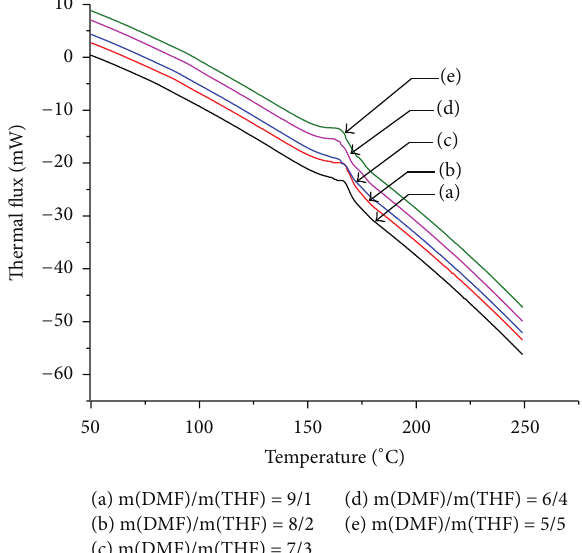
Figure 8: The X-ray diffractogram of PVDF/PEI composite fiber membrane prepared by electrospinning with different solvent ratios. Figure 9: The DSC curves of different solvent ratio PVDF/PEI